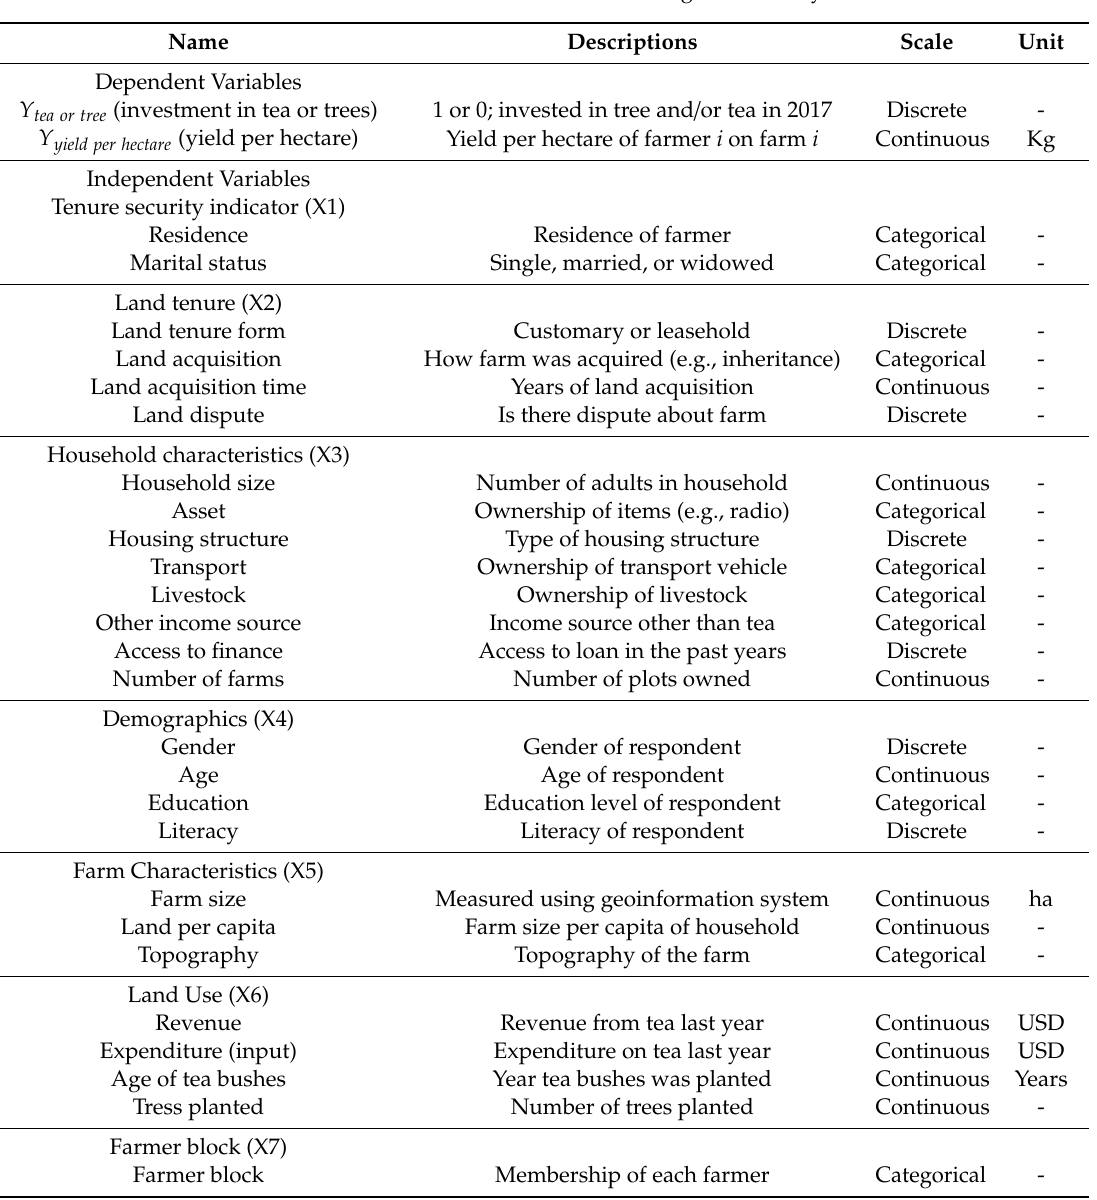
Table 2. Overview of variables used for the regression